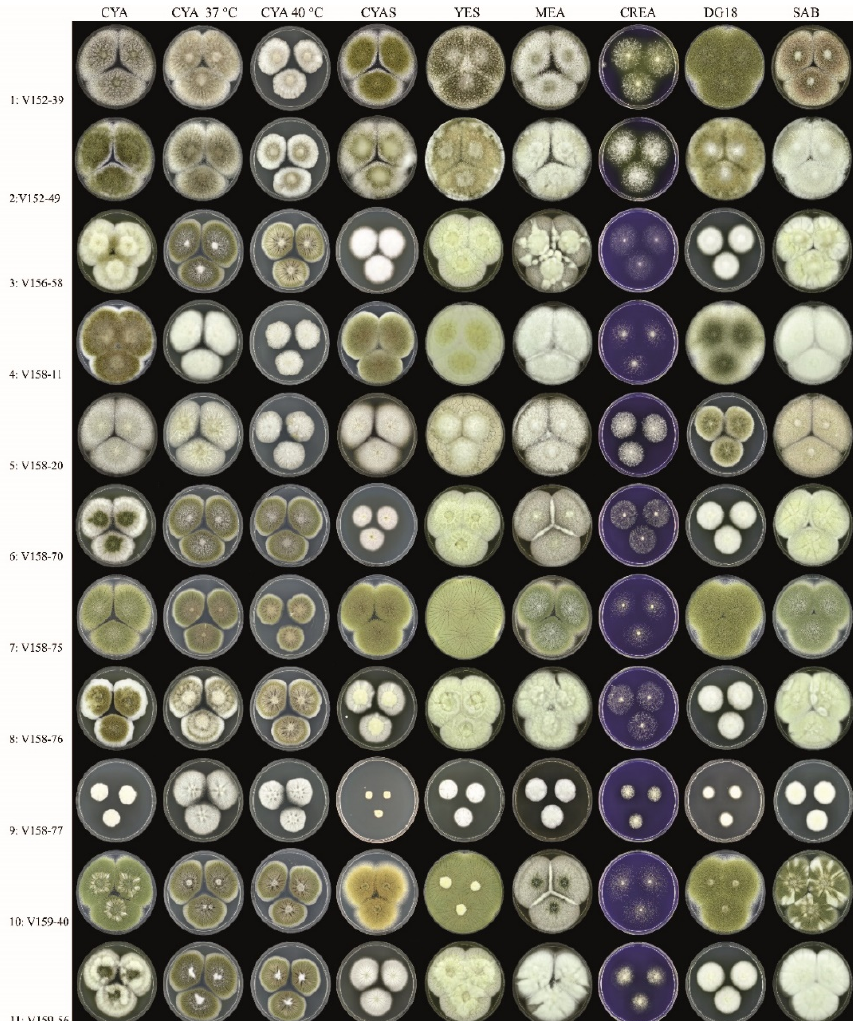
Figure 4. Overview of the phenotypic diversity of A. flavus isolates (all obverse, 7 days at 25 °C, unless stated otherwise). Columns, left to right: Czapek yeast extract agar (CYA), CYA incubated 37 °C, CYA incubated 40 °C, CYA supplemented with 5% NaCl (CYAS), yeast extract sucrose (YES), malt extract agar (MEA), creatine agar (CREA), dichloran 18% glycerol agar (DG18), Sabouraud dextrose agar (SAB). Rows, top to bottom: Isolates 1–11.